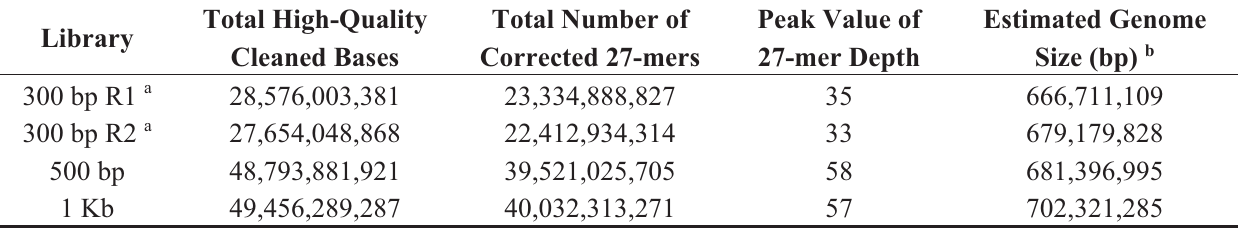
Table 1. Bemisia tabaci Middle East-Asia Minor 1 (MEAM1) genome size estimation by k-mer analysis.